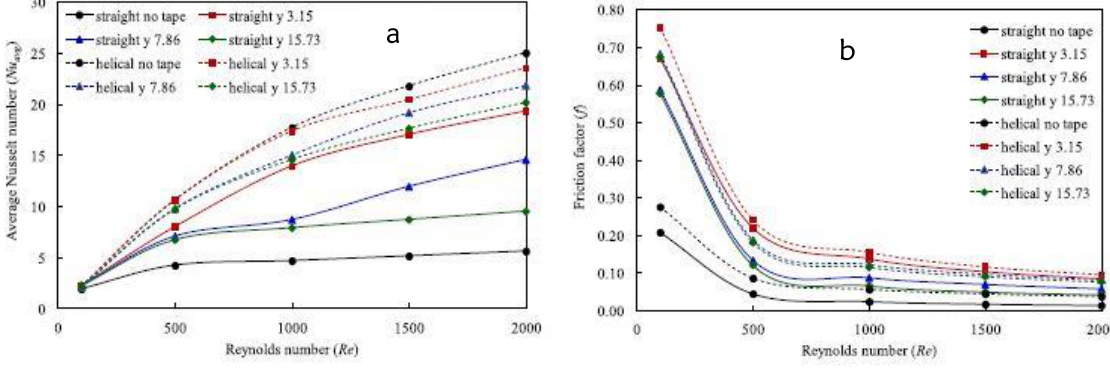
Figure 10: (a) Average Nusselt number of air flow for various configurations at T wall = 333.15 K. (b) Friction coefficient of air flow for various configurations at T wall =333.15 K [17].